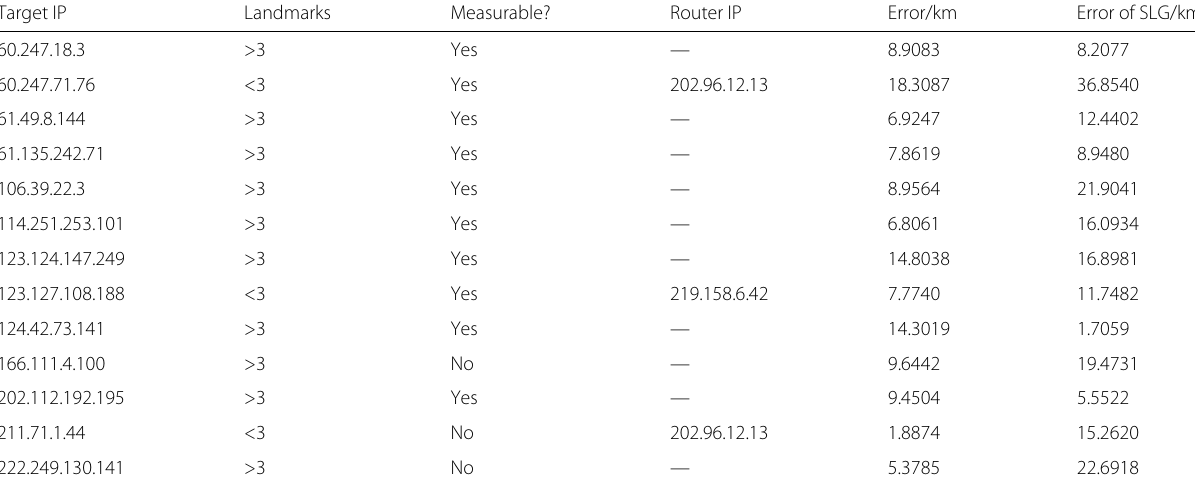
Table 3 Geolocation results compared to SLG Target